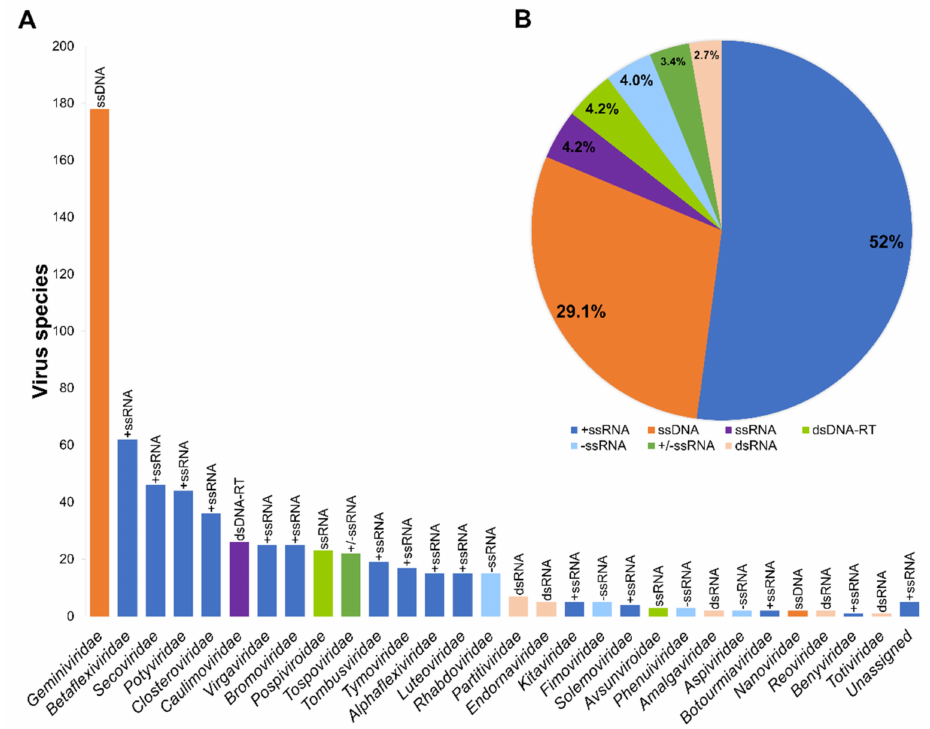
Figure 3. Classification of 617 plant viruses infecting EFFs. ( A ) The number of virus species identified in each family is shown. Virus families are indicated by color code according to the nature of their genomes (above each bar). ( B ) Percentage of viruses containing RNA (+ssRNA, − ssRNA, +/ − ssRNA, ssRNA, and dsRNA) or DNA (ssDNA and dsDNA-RT)